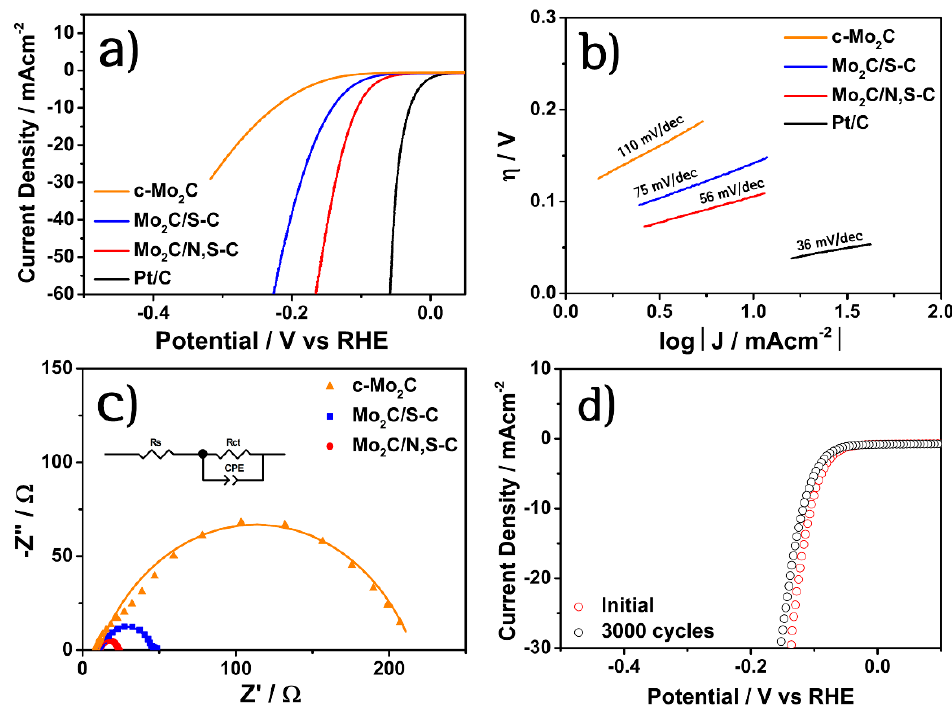
Figure 3. ( a ) Polarization curves of all prepared samples in 1 M KOH solution, ( b ) Tafel plots, ( c ) Nyquist plots with an equivalent circuit, and ( d ) stability tests of Mo 2 C/N,S-C.